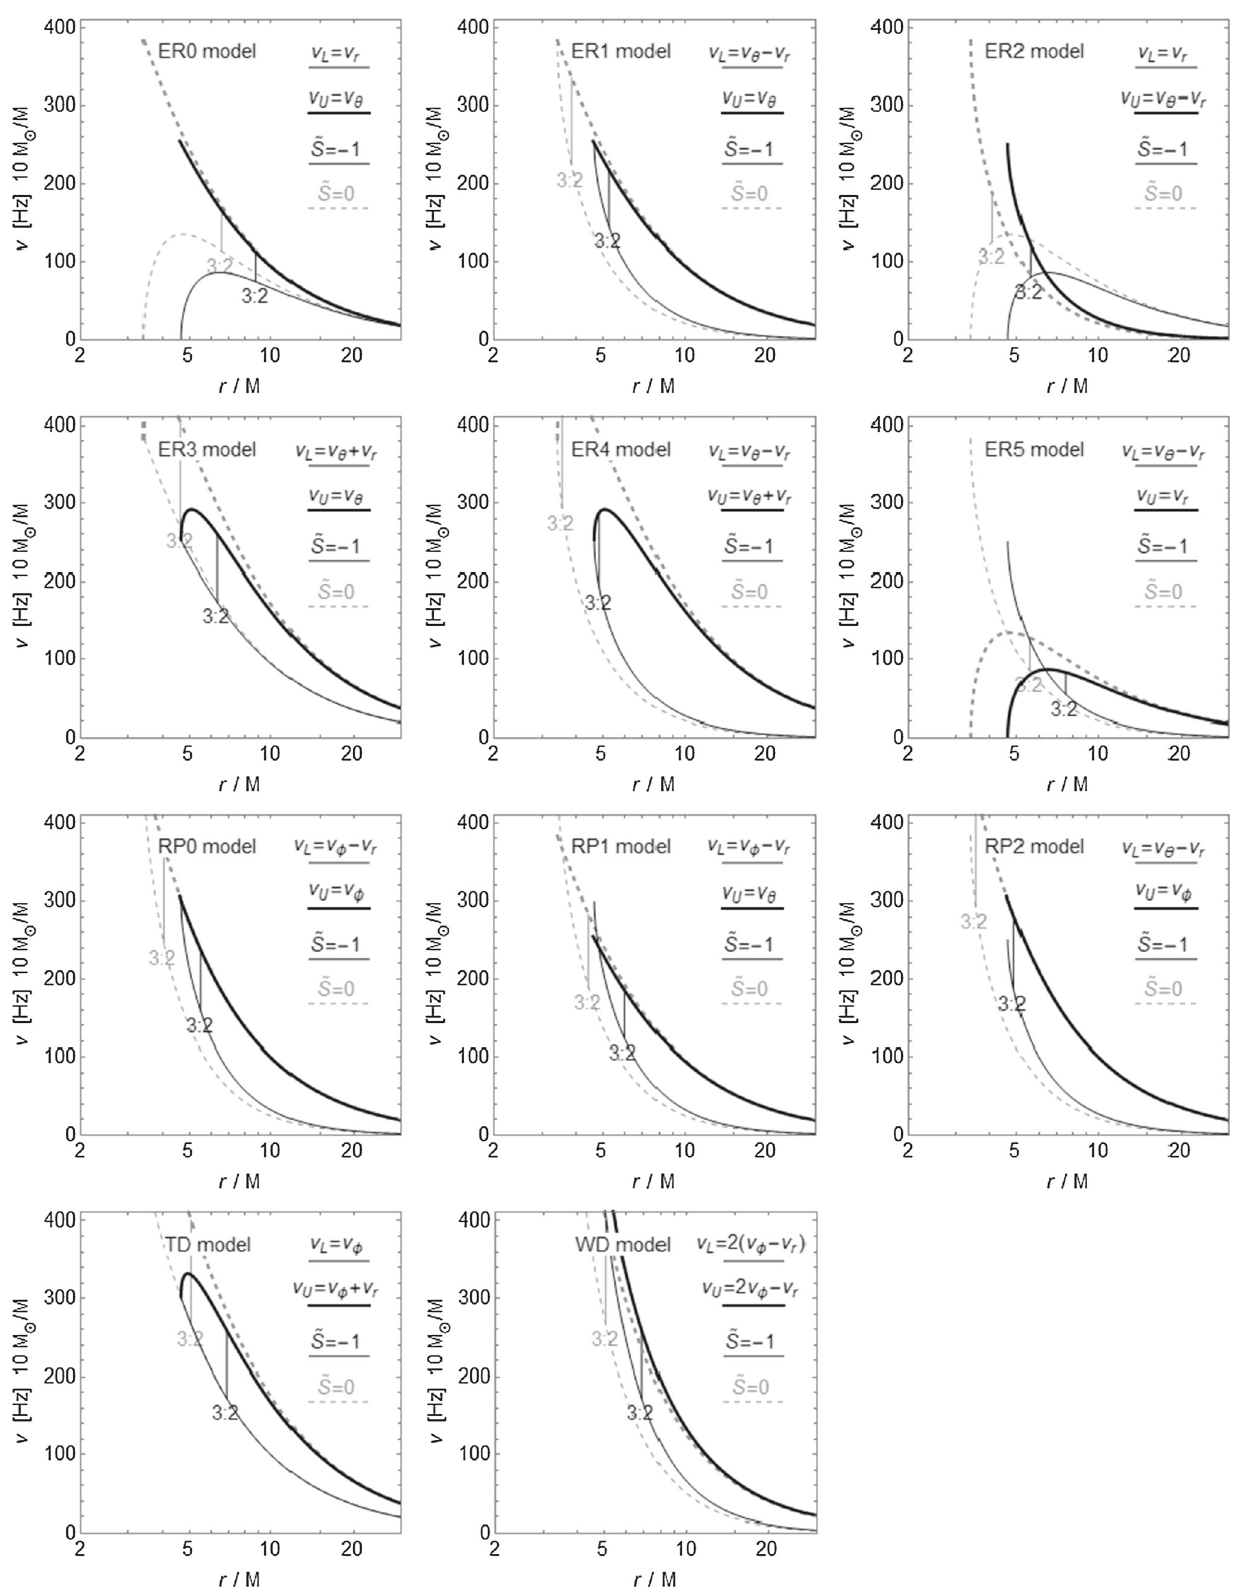
Fig. 5 Radial profiles of lower ν L ( r ) and upper ν U ( r ) frequencies for various HF QPOs models, see Sect. 3.1. We compare the frequencies for neutral non-spinning particles ( ˜ S = 0, gray curves) with the neutral